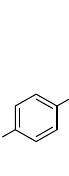
Figure 30. Chemical structure of compound 88 .